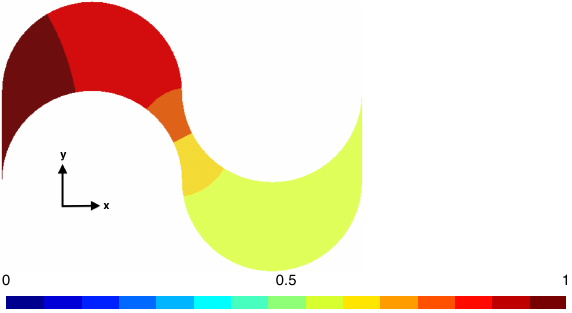
Figure 3. Concentration in a tortuous